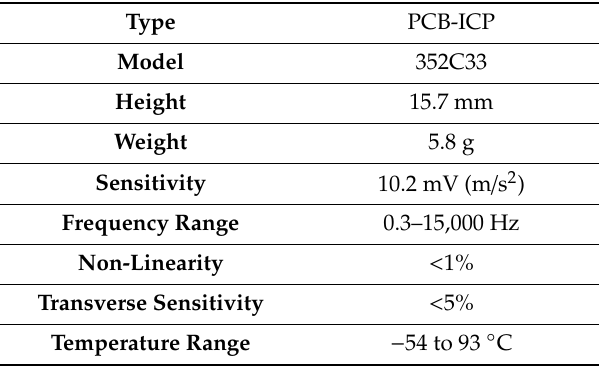
Figure 3. Fundamental longitudinal resonant frequency test. Table 5. Accelerometer